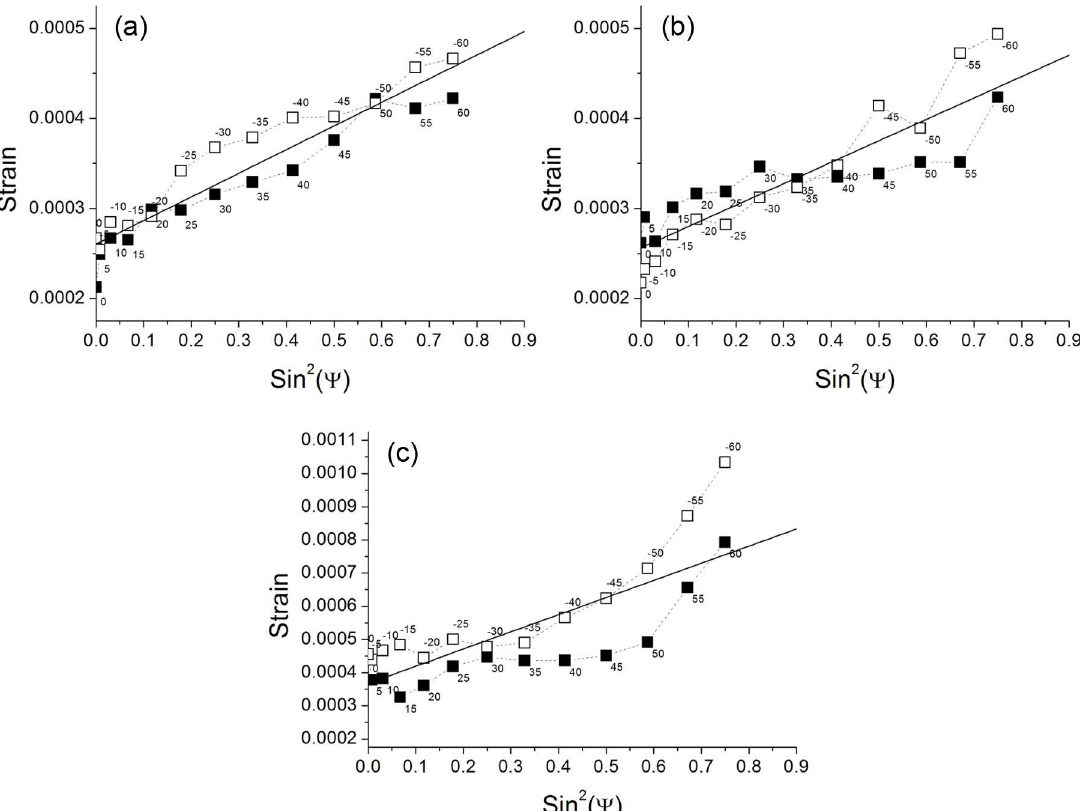
Figure 9. Curves of strain in function of sin 2 (Ψ): (a) surface 1 of modified sample (residual stress of 23 MPa), (b) surface 2 of modified sample (residual stress of 21 MPa) and (c) surface of reference sample (residual stress of 46 MPa). White and black squares represent the Ψ angles used for the measurements (black are positive angles and white are negative angles).